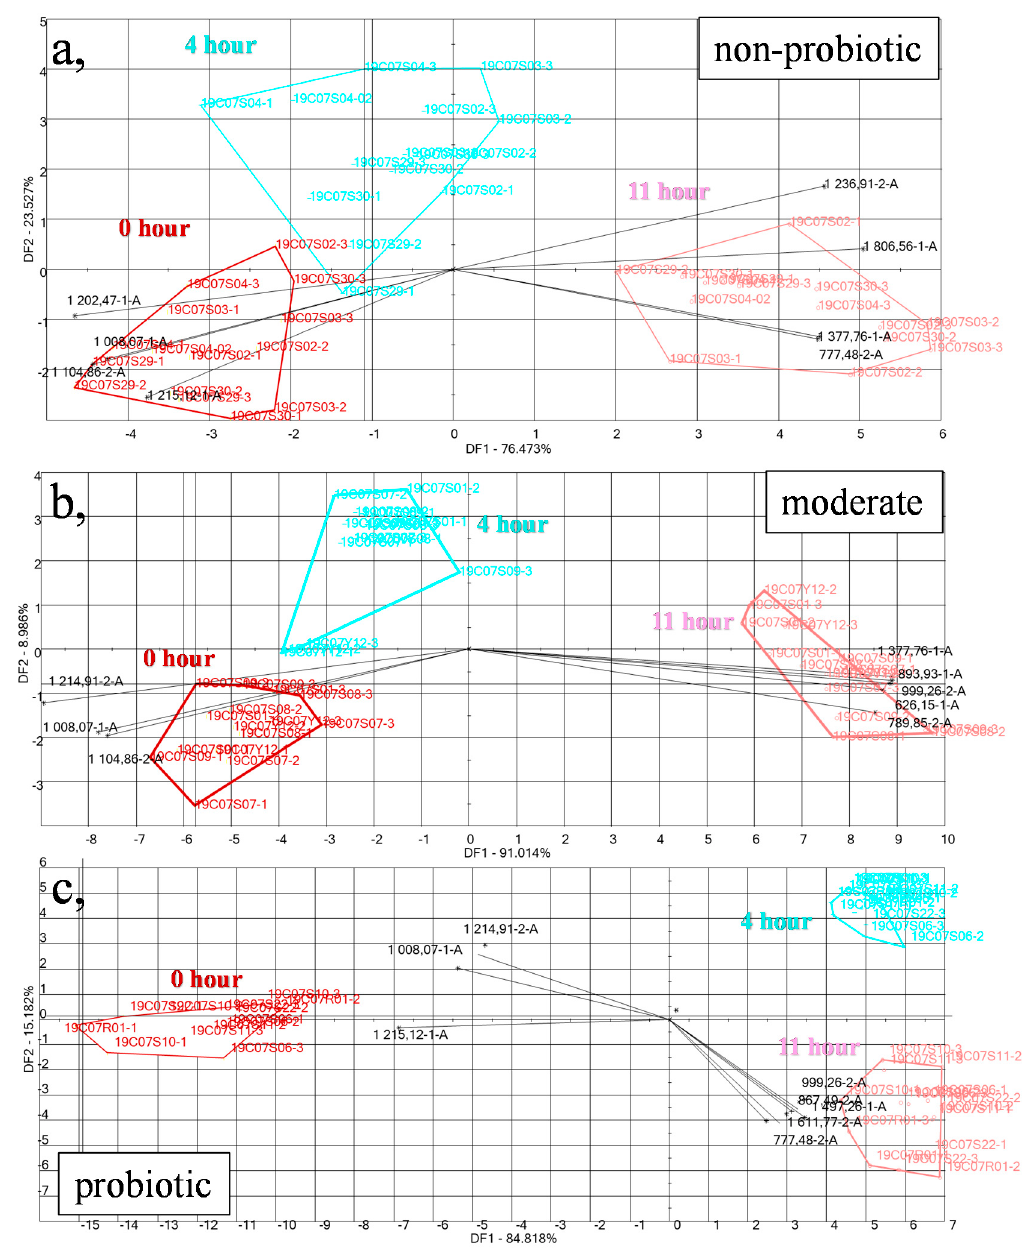
Figure 6. Discrimination of the milk samples inoculated with the 15 bacteria strains based on the incubation time using their aroma composition measured by the e-nose for the group of ( a ), non-probiotic ( n = 45), ( b ), moderately probiotic ( n = 45), and ( c ), probiotic ( n = 45) strains.